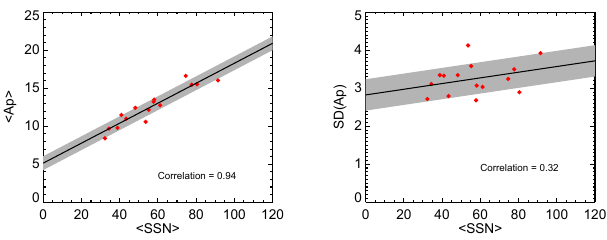
Figure I2. Regression of Ap bg (red symbols, left) and SD(Ap a ) SC (red symbols, right) to < SSI > . The resulting linear fit is shown by black lines, the grey shaded areas reflect the RMS